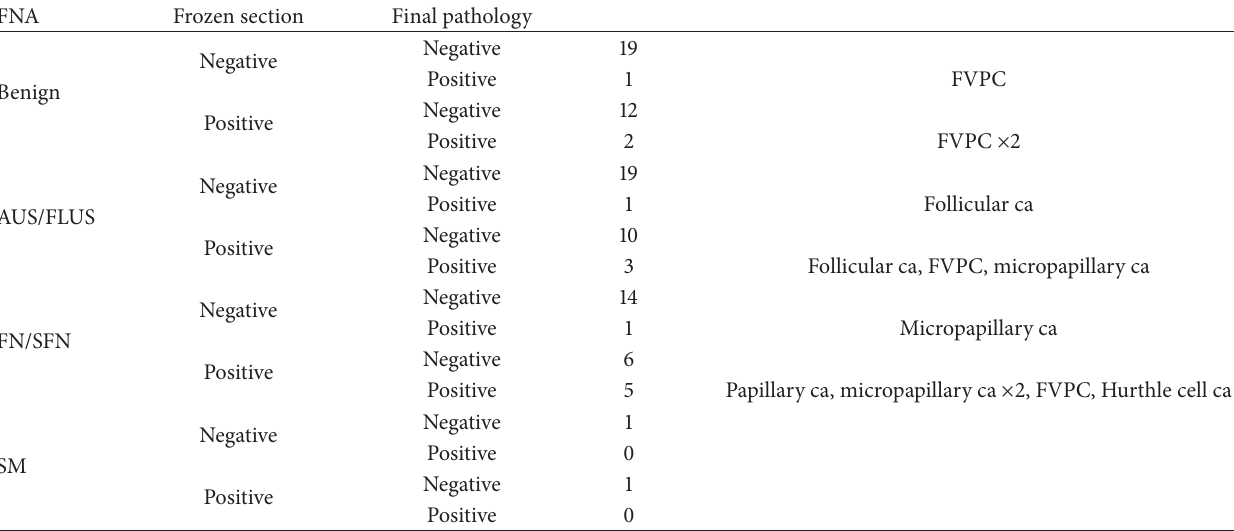
Table 3: Fine needle aspiration (FNA) Bethesda Criteria and frozen section (FS) compared with final pathology.